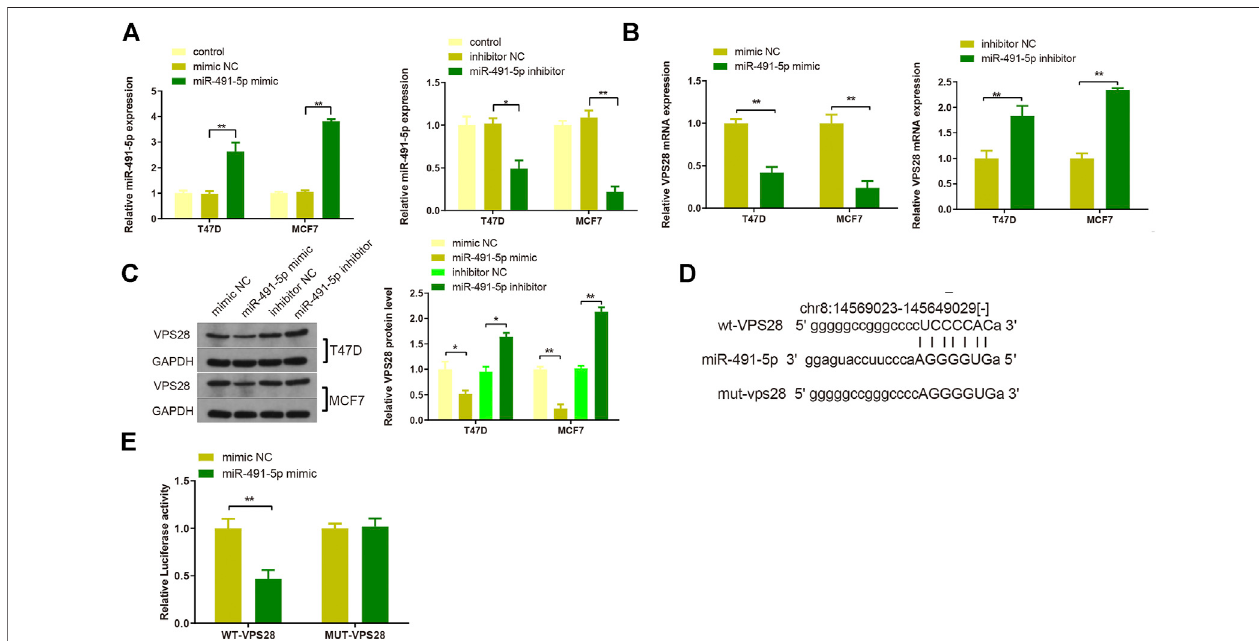
FIGURE6| Thetransfectionef fi ciencyofT47DandMCF7cellswithmiR-491-5pwasdeterminedbyqRT-PCR (A) .mRNAandproteinexpressionsofVPS28were detectedbyqRT-PCR (B) andWesternblot (C) .ThepredictedbindingsiteofmiR-491-5pand VPS28 3 ′ UTRasdeterminedbyTargetScan (D) .ThebindingofmiR-491- 5p to VPS28 was determined using the dual luciferase reporter assay (E) . ** p < 0.01, *** p < 0.01, n (cid:1)